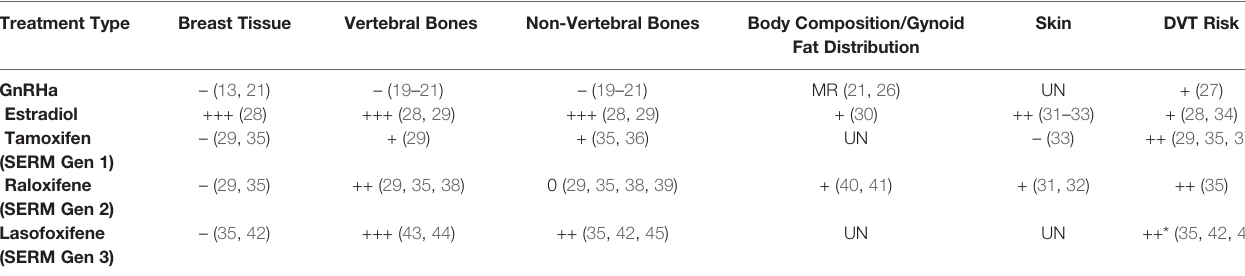
TABLE 1 | Differential effects of GnRHa, SERMs, and